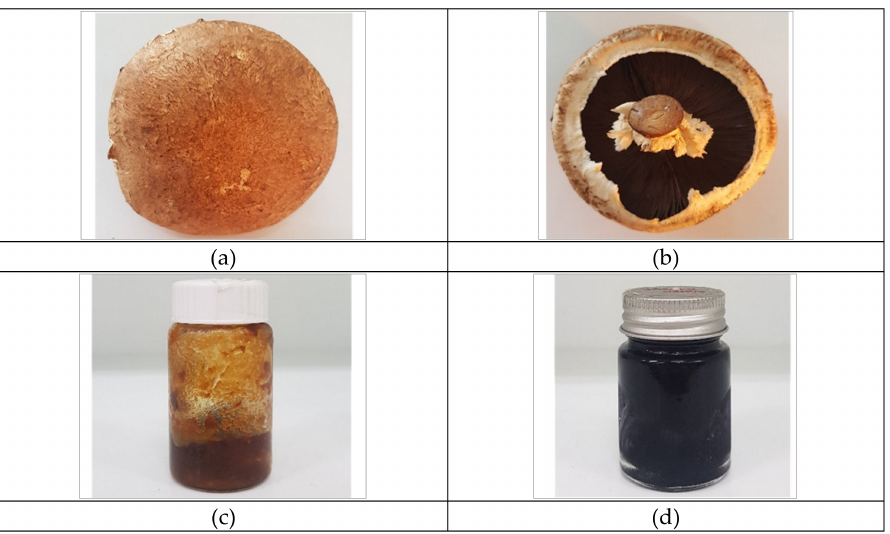
Figure 1. The physical appearances of ( a , b ) fruiting body of brown A. bisporus , ( c ) brown A. bisporus ethanol extract, and ( d ) brown A. bisporus water